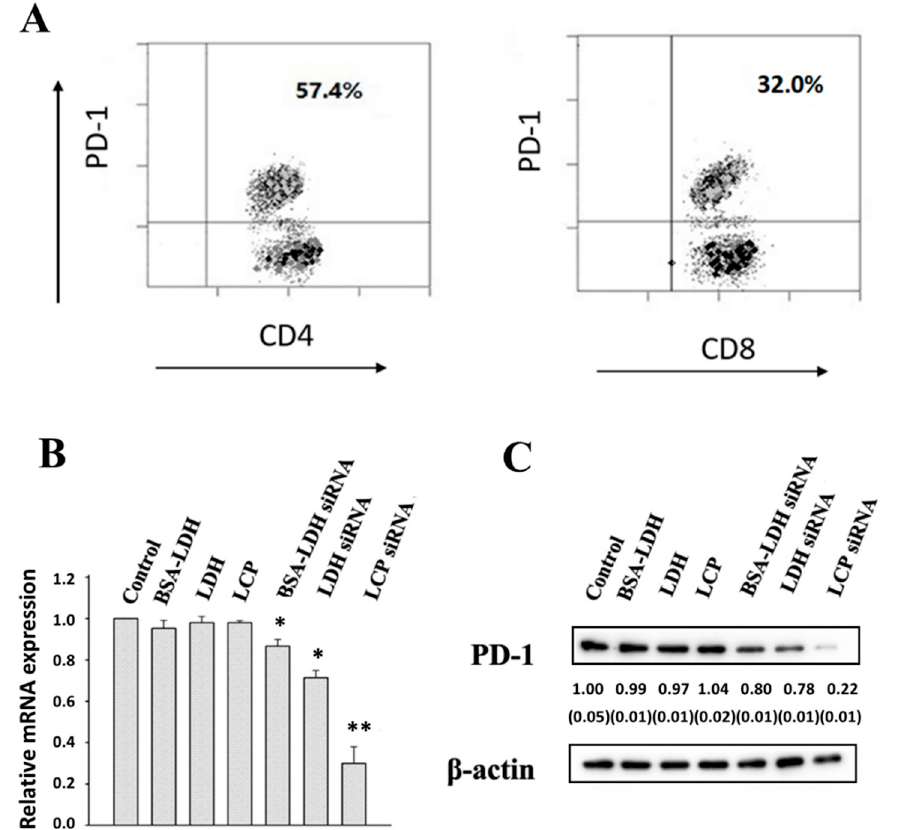
Figure 3. PD-1 expression and down-regulation of PD-1 in EL4. ( A ) PD-1 expression in gated CD4 and CD8 positive T cells (32.0%). ( B ) Real-time PCR data for the knockdown efficiency of PD-1 mRNA in EL4 treated with BSA-LDH-siRNA-PD-1; LDH-siRNA-PD-1; LCP-siRNA-PD-1 at the concentration of 80 nM for 4 h; and, ( C ) Western-blot showing the reduction of PD-1 expression in EL4 cells